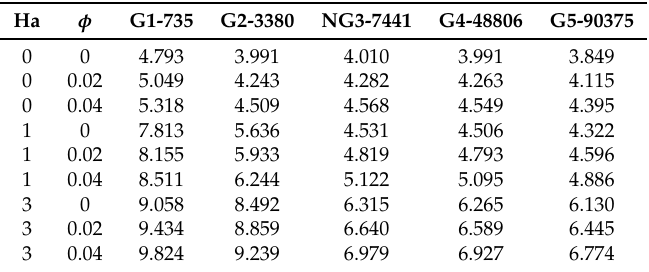
Table 2. Grid independence study for various grid sizes: Average Nusselt number for the hot walls of the branching channel for various combinations of Hartmann number and solid particle volume fraction (Re = 500).